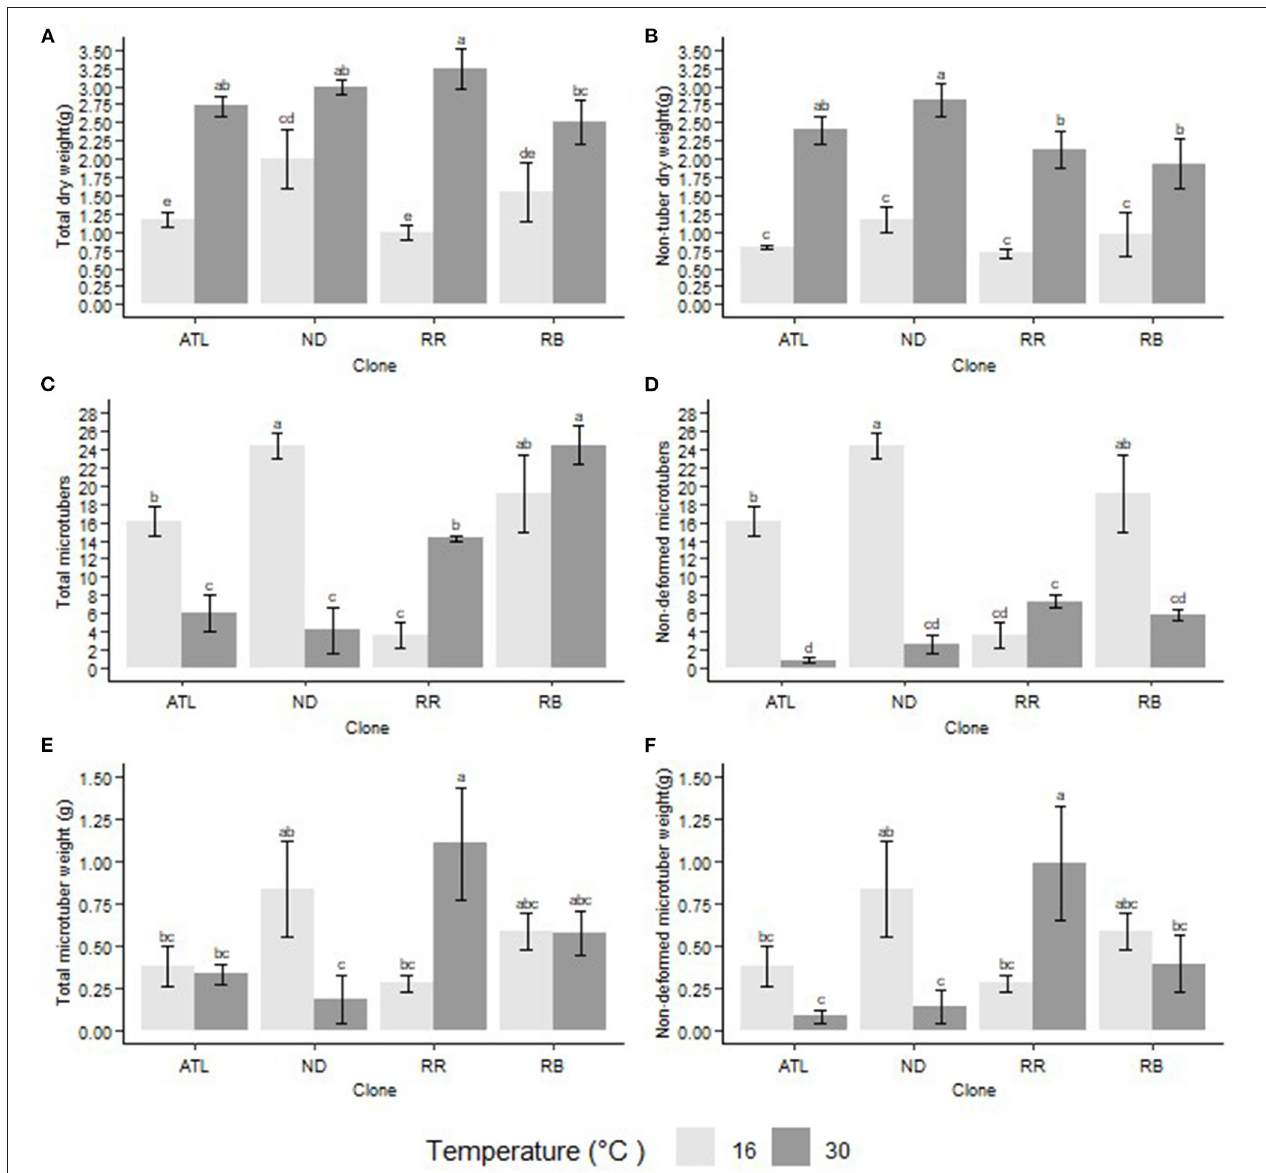
FIGURE 1 | Interaction of temperature and clone on different traits. (A) Total biomass (dry) per explant, (B) Non-tuber biomass (dry) per explant, (C) Total microtuber number per explant, (D) Non-deformed microtuber number per explant, (E) Total microtuber weight (dry) per explant, (F) Non-deformed microtuber weight (dry) per explant. The following potato clones were used in the experiment: ATL (Atlantic), ND (NDTX081648CB-13W), RR (Reveille Russet), and RB (Russet Burbank). Clones with the same letter were not significantly different at p ≤ 0.05.